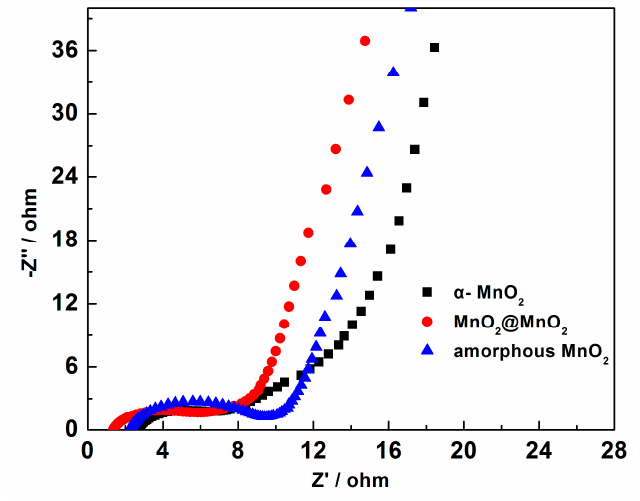
Figure 9. Nyquist plots of the electrochemical impedance spectroscopy for the three electrodes.